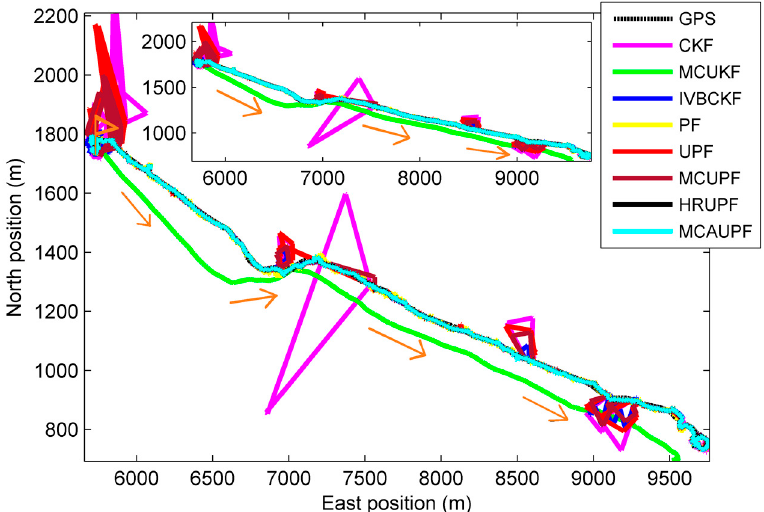
Figure 7. Paths taken by the proposed filter and existing filters.